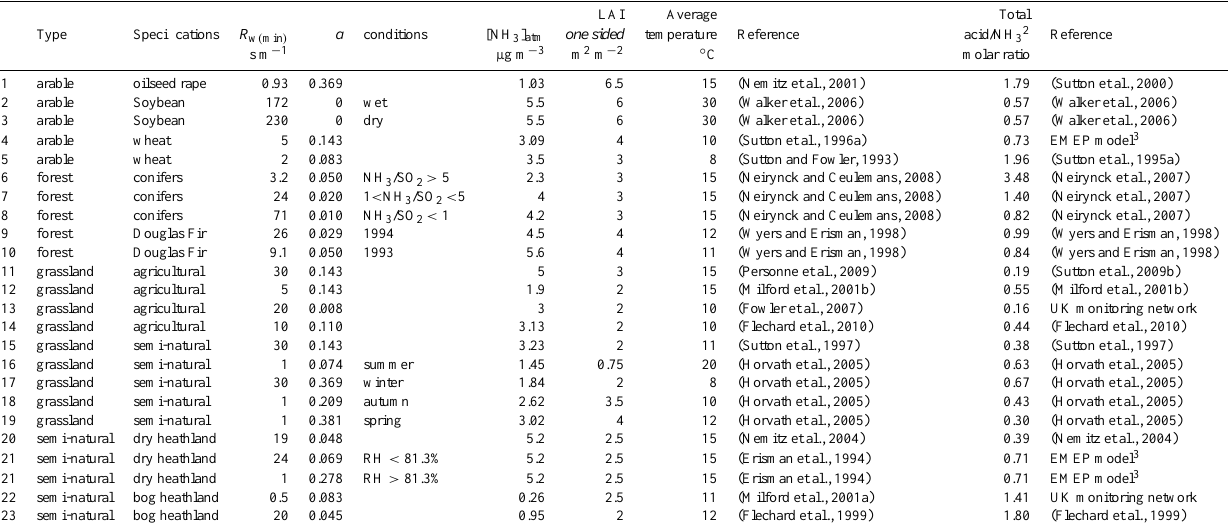
Table 1. Compiled data of R w as a function of RH 1